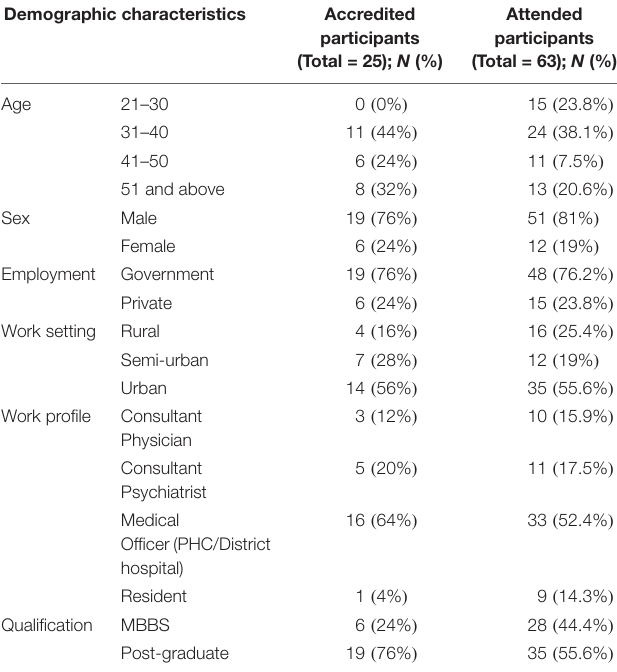
TABLE 1 | Demographic characteristics of certified participants. Demographic